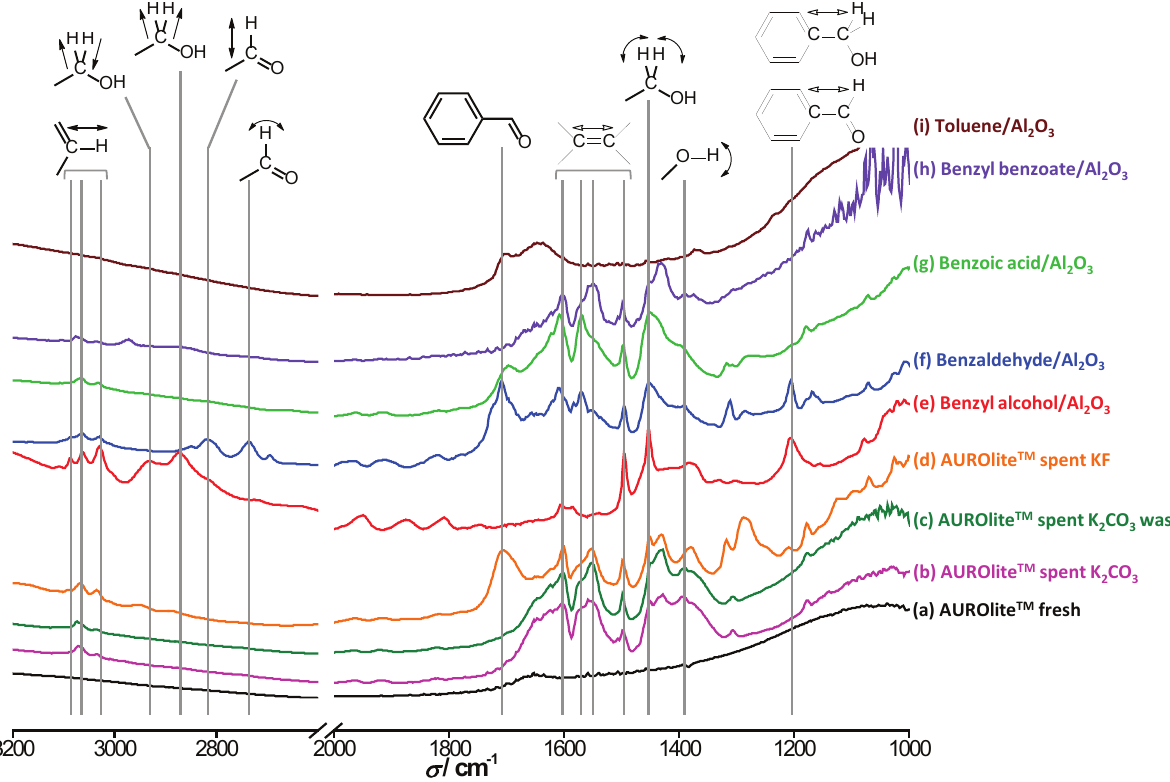
Figure 13. DRIFT spectra of ( a ) fresh AUROlite ™ catalyst; ( b ) used with K with K CO and washed in boiling water; ( d ) used with KF, ( e )–( i ) reference compounds 2 3 adsorbed on alumina. Catalyst samples were pretreated under He at 473 K before